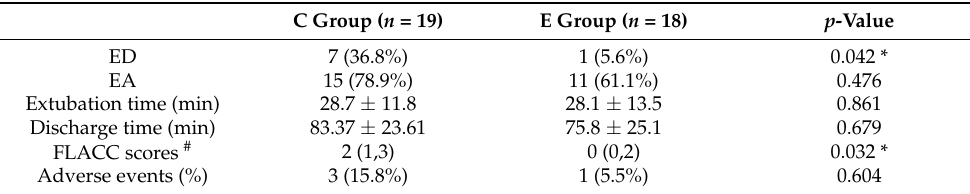
Table 2. Primary and secondary outcomes in the PACU.